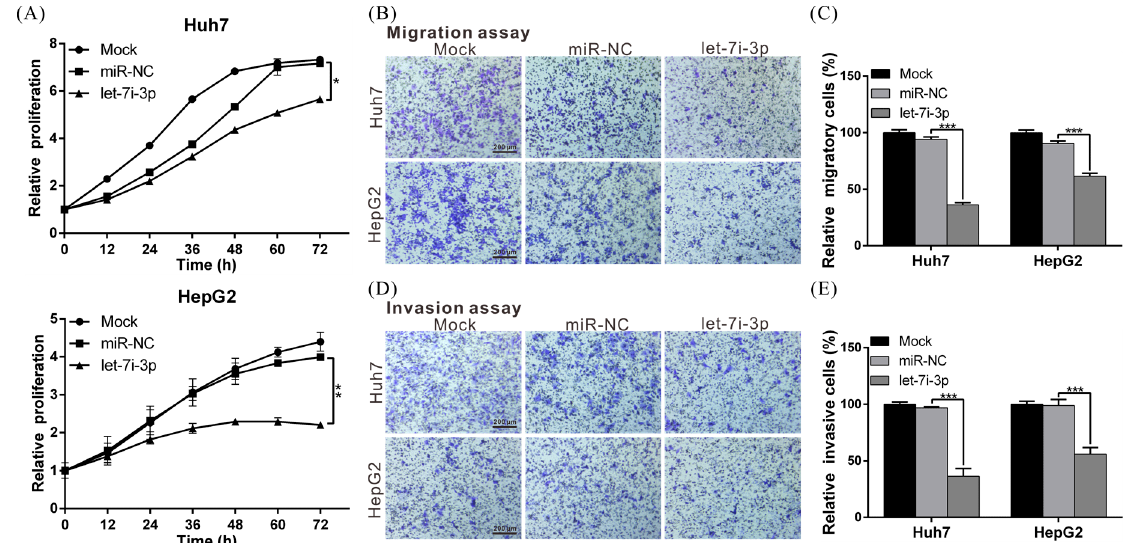
Figure 3. miRNA let7i-3p suppresses the proliferation, migration and invasion capacities of HCC cells. ( A ) Huh7 and HepG2 cells were transfected with 50 nM let7i-3p mimic or control miRNA (miR-NC), and the cell proliferation rate was monitored at the indicated times using an xCELLigence real-time cell analyzer. ( B , D ) Transwell assays were performed to examine the effect of let7i-3p on the migration and invasion capacities of HCC cells, and the results were quantified ( C , E ). All experiments were performed in triplicate; * p < 0.05, ** p < 0.01, *** p < 0.001. Magnification: 100 × . Scale bar = 200 µ m.